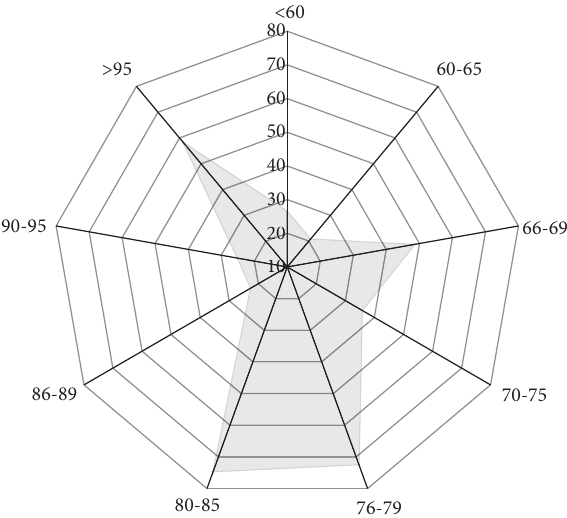
Figure 8: Results of the cross-tabulation of age and aged care needs services for older people. Figure 7: Schematic representation of the cost of inclusive,